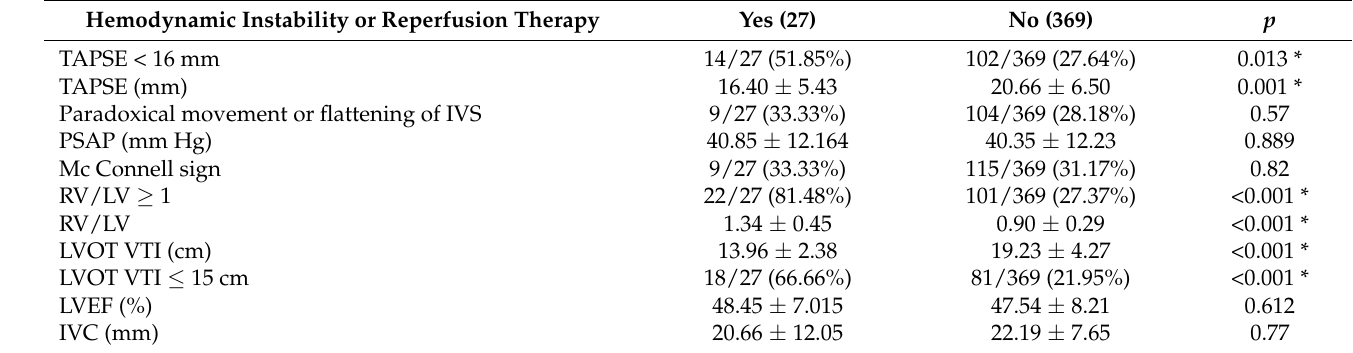
Table 6. Comparative baseline echocardiographic parameters in patients with and without in hospital hemodynamic instability or need of reperfusion therapy.